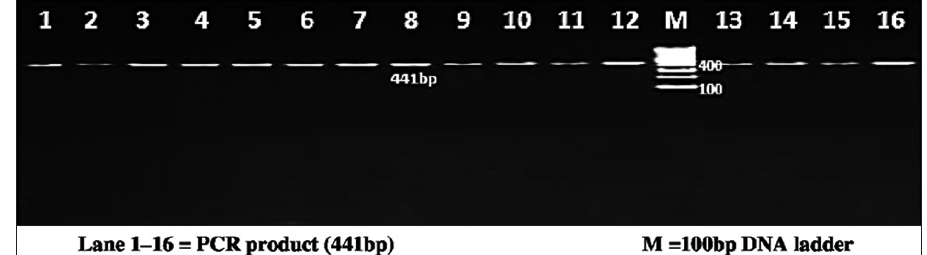
Figure-3: Resolution of polymerase chain reaction (PCR) amplified product of Primer 3 on 2% agarose gel. Lane 1-16=PCR product (441 bp), M=100 bp DNA ladder.